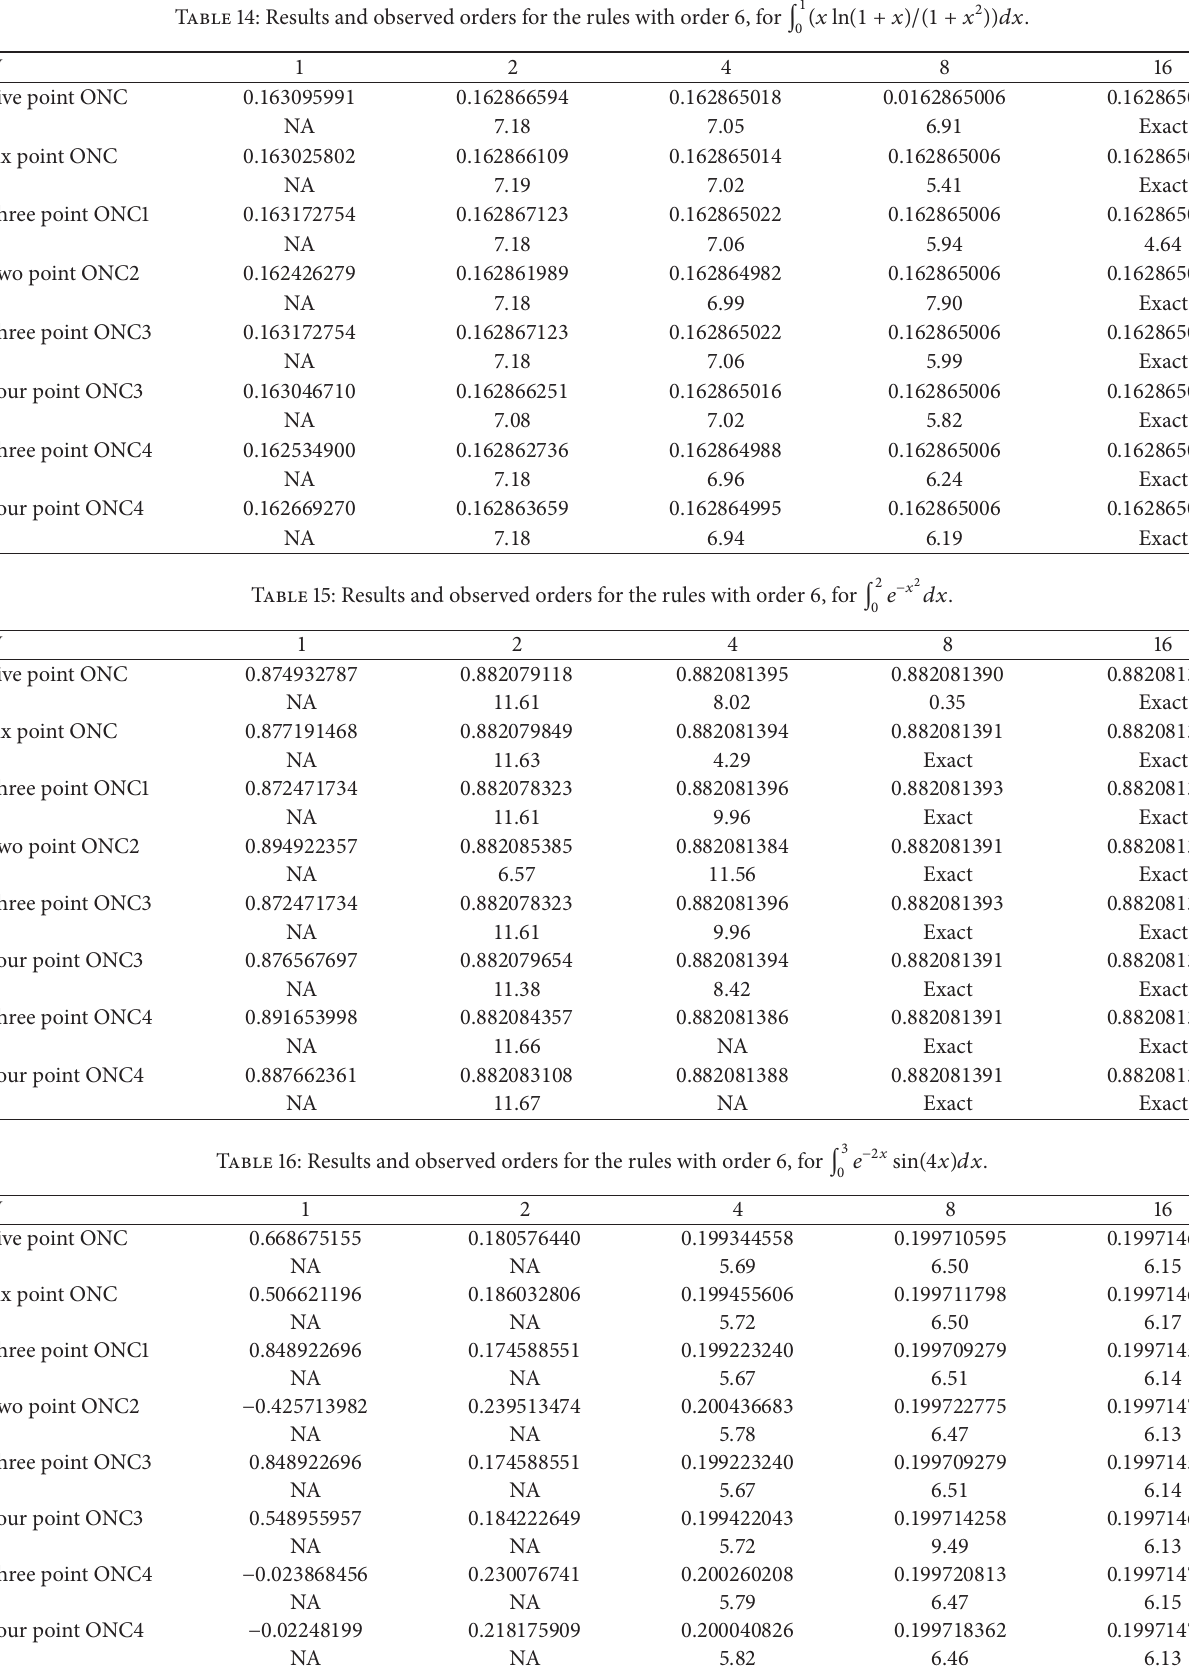
Table 14: Results and observed orders for the rules with order 6, for ∫